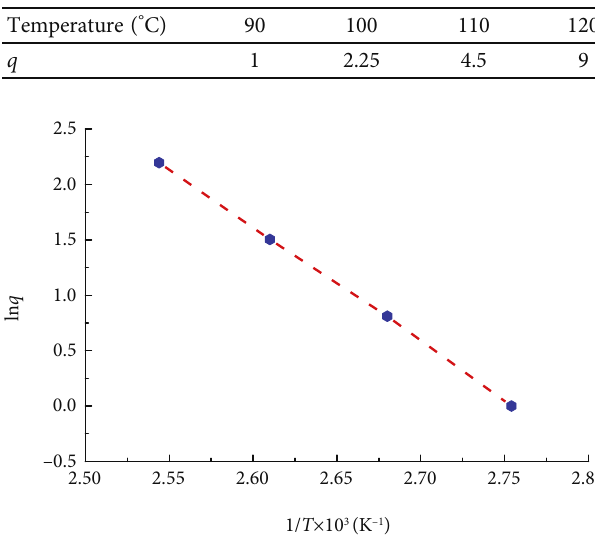
Table 4: The reaction rate ratio at the di ff erent temperature.